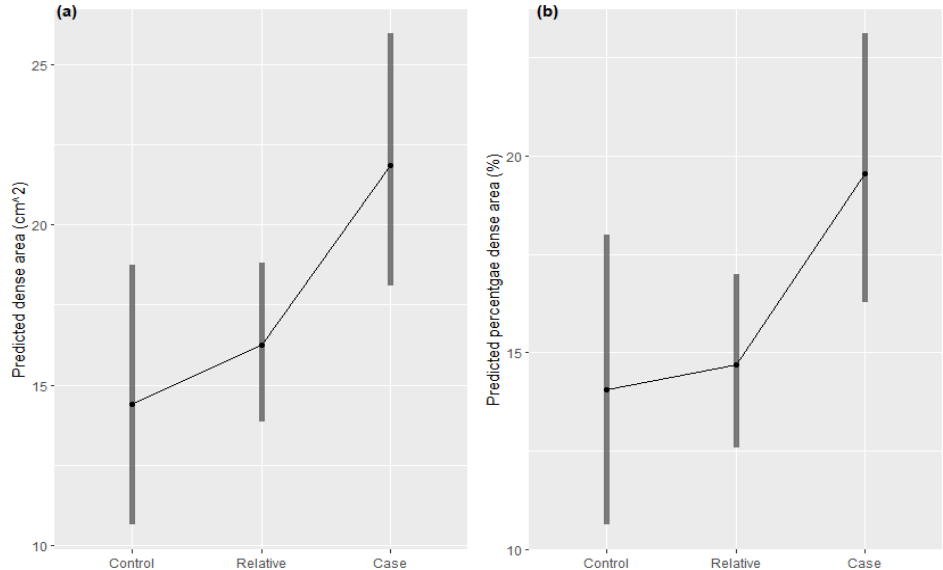
Figure 1. Estimated marginal means for dense area ( a ) and percentage dense area ( b ) adjusted for age, BMI, time between BMI measurement and mammogram and the GRM by case, relative and control status for kConFab sample.